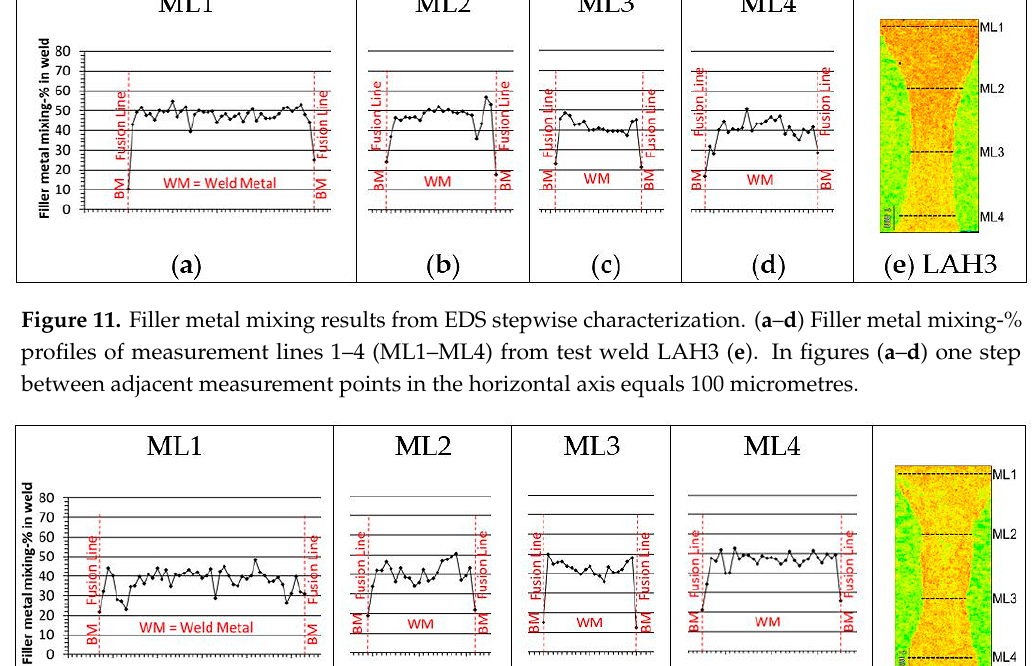
Figure 10. Average values of filler metal mixing-% from the data of measurement lines ML1–ML4 in laser-arc hybrid test welds.